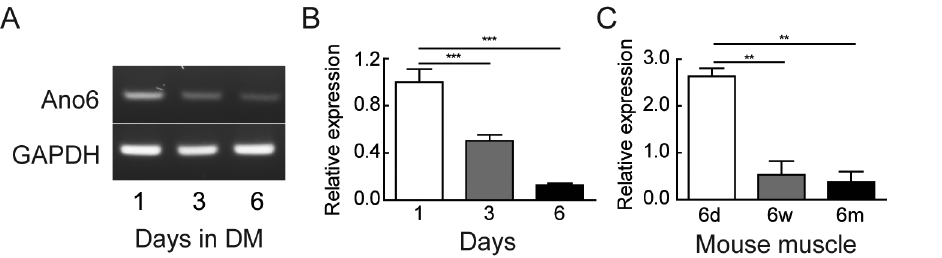
Figure 1. Expression of Ano6 in C2C12 muscle cells and mouse skeletal muscle. (A) Semi-quantitative RT-PCR analysis of Ano6 and GAPDH expression in C2C12 cells during differentiation. (B) Relative expression of Ano6 (normalized to GAPDH) examined by qRT-PCR in C2C12 cells during differentiation. (C) Relative expression of Ano6 (normalized to GAPDH) examined by qRT-PCR in the quadriceps muscles of mice at 6 days, 6 weeks and 6 months of age. **p , 0.01; ***p , 0.001.